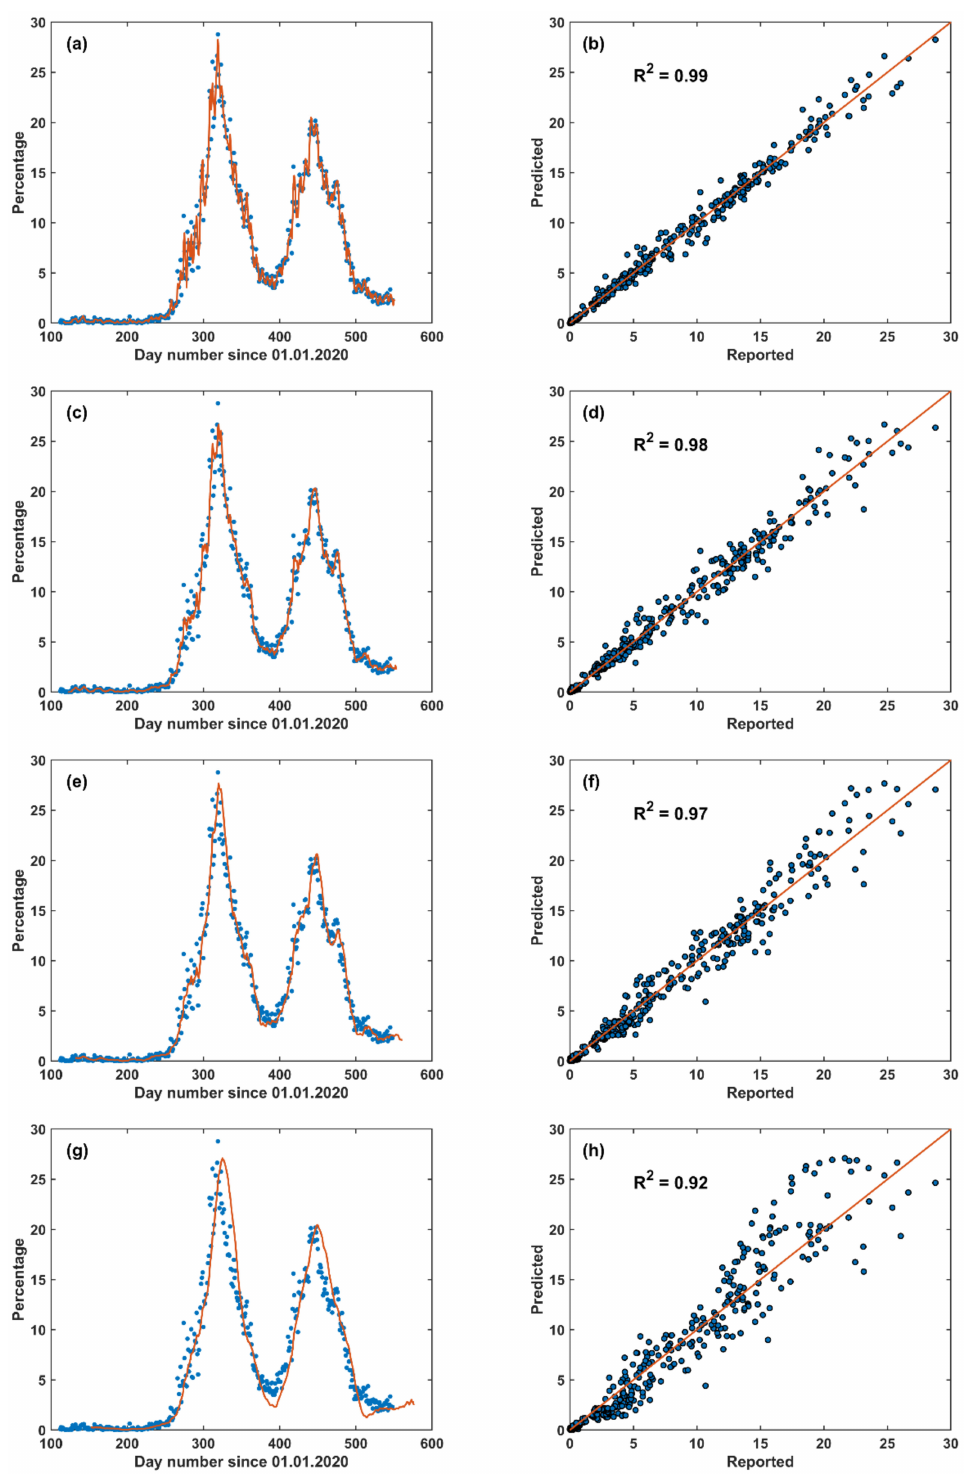
Figure 8. Short-term forecast (STF) models (Equation (1)) for the COVID-19 pandemic in Jordan based on the positive qPCR cases out of the performed daily tests (as percentage out of the total qPCR daily tests): ( a , b ) previous 5 days learning, ( c , d ) previous 10 days learning, ( e , f ) previous 20 days learning, ( g , h ) previous 40 days learning. The left panel is the time-series of the percentage of the daily positive qPCR tests percentage and the right panel is the corresponding scatter plots between the forecasted and the reported daily positive qPCR tests percentage. Legend of the left panel: (dots) reported and (line)